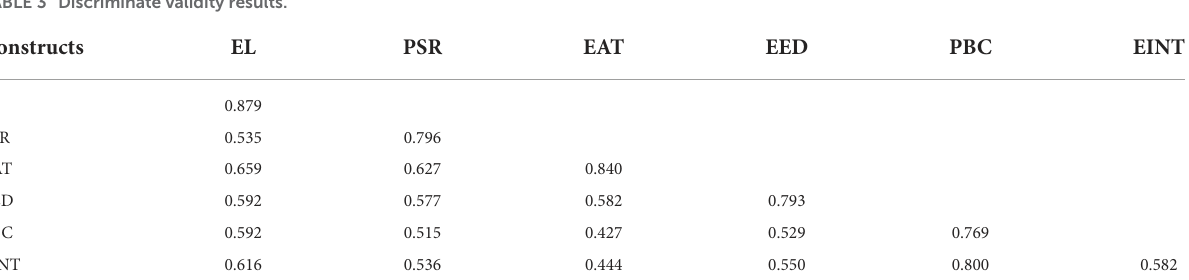
TABLE 3 Discriminate validity